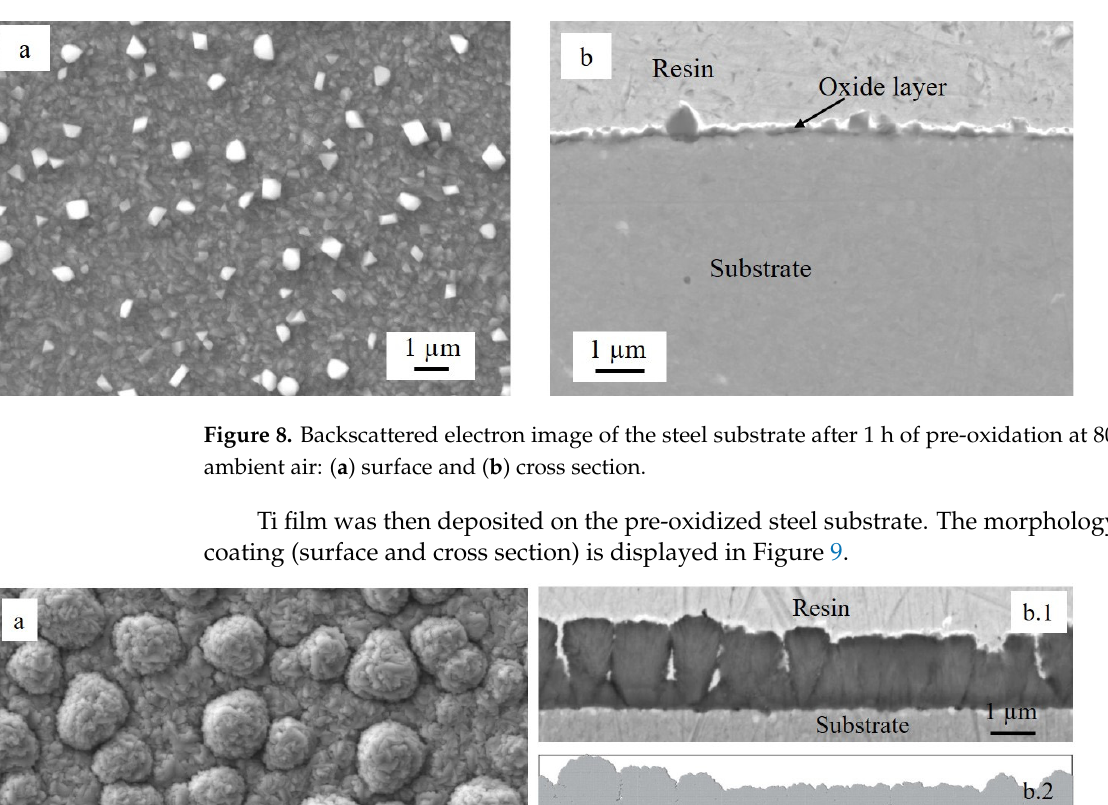
Figure 7. Magnification of the oxide layer formed in the case of the Ti-coated sample after 100 h aging at 800 °C under laboratory air.